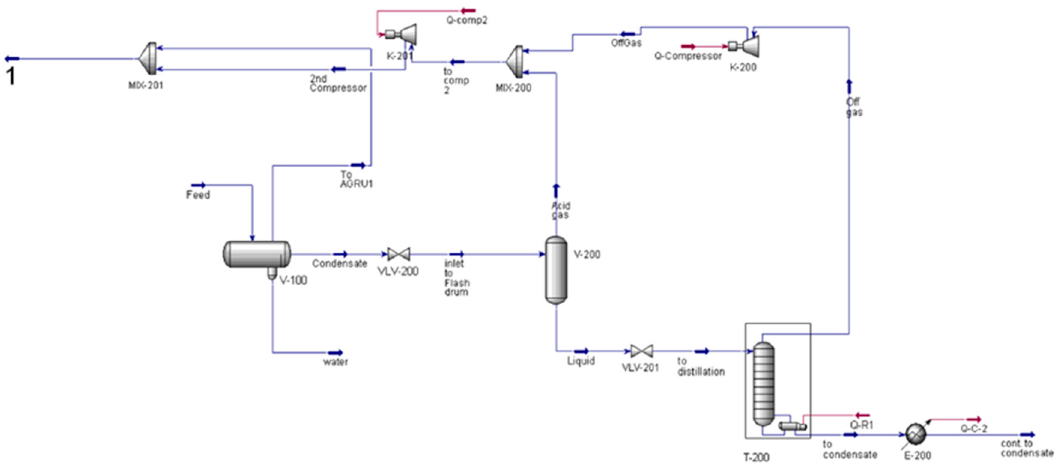
Figure 3. ASPEN HYSYS simulation of gas stabilization unit.